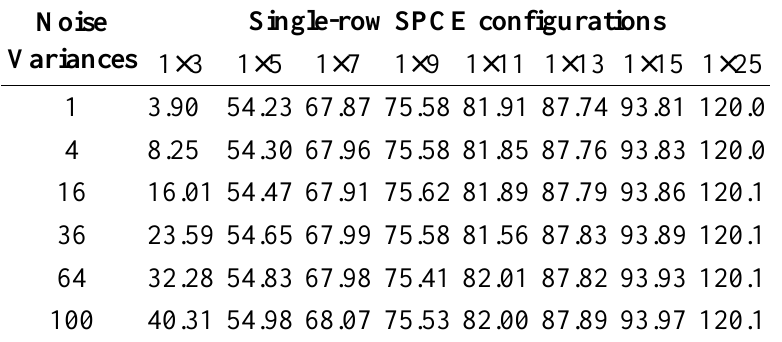
Table 3. Relative errors in percent of the ego-translation for different single-row SPCE configurations with various noise variances after a small